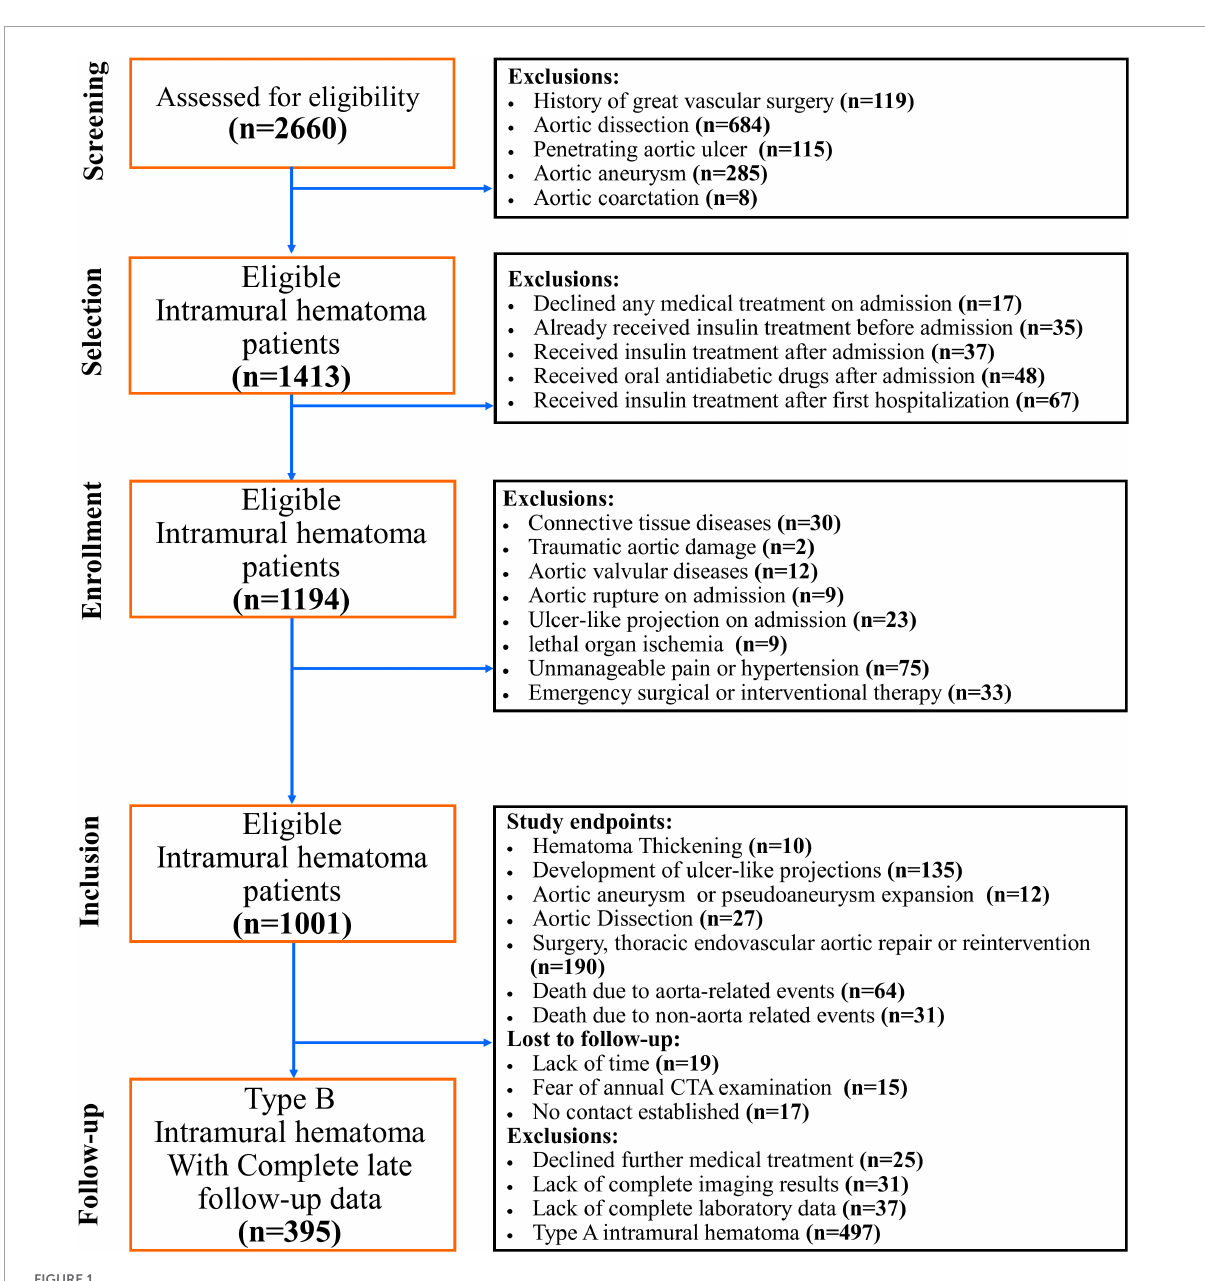
FIGURE1 CONSORT diagram. This graphic illustrates the CONSORT diagram of the patient selection process. From January 2007 to December 2020, a total of 96 matched IMHB patients who received the “wait-and-watch strategy” in a single institution were included in this study. Patients who declined medical care, those who did not have CTA images to assess the progression of IMHB, those who did not have complete laboratory data, and those who could not be communicated for follow-up were all considered to be missing